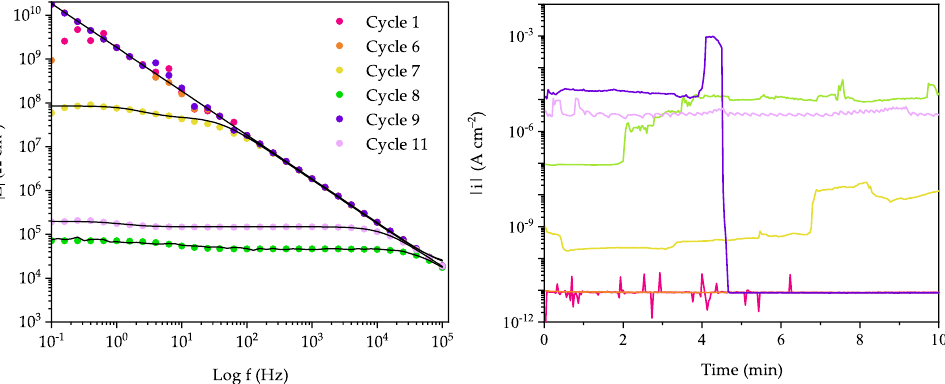
Figure 3. Evolution of the Bode modulus spectra at OCP ( left ; fitted spectra as black lines) recorded after each potentiostatic anodic polarization at 0 V vs. SCE ( right ) of a co-PPM 9% coating. Same colors for the two plots: magenta 1st cycle, orange 6th, yellow 7th, green 8th, purple 9th, and pink 11th.